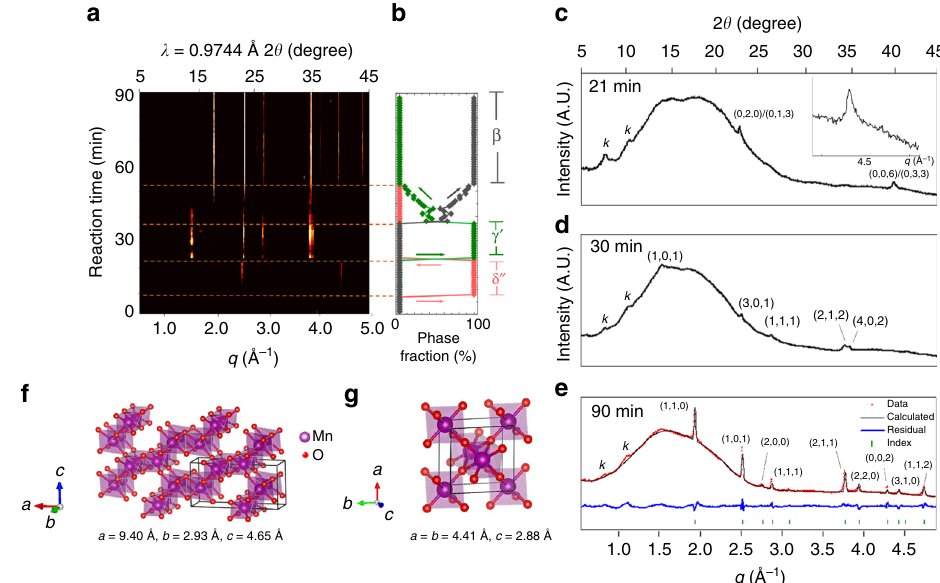
Φ Þ = d μ ¼ (cid:2) 0 : 21 , which means that the driving force α (cid:2) K 0 : 125 MnO 2 K 0 : 33 MnO 2 (cid:2) K